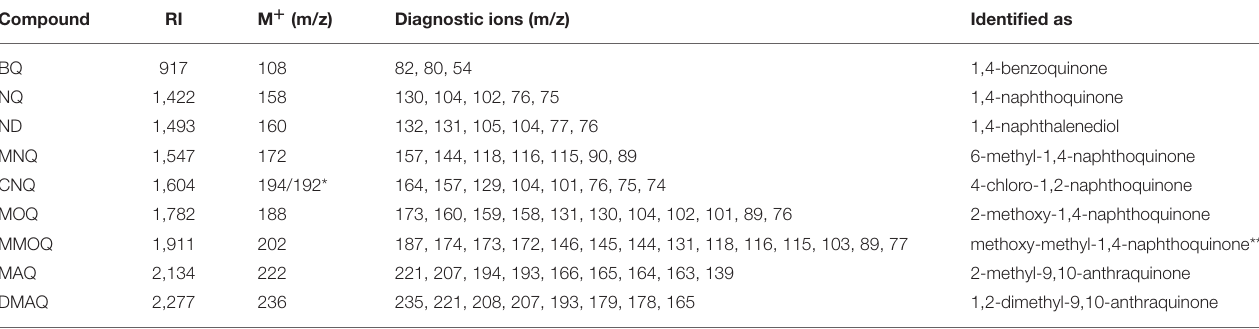
TABLE 1 | Gas chromatographic – mass spectrometric data to quinones from Palpatores. Compound RI Diagnostic ions